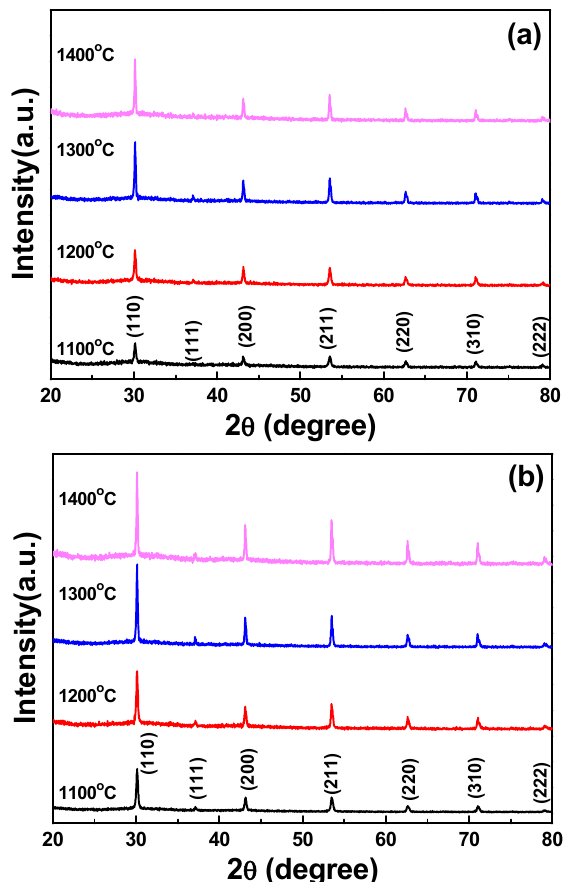
Figure 2. X-ray diffraction (XRD) patterns of BaZrO 3 :Eu 0.025 powders as a function of heating process and heating temperature. ( a ) One-step Eu-BZO powder and ( b ) Two-step Eu-BZO powder, respectively.